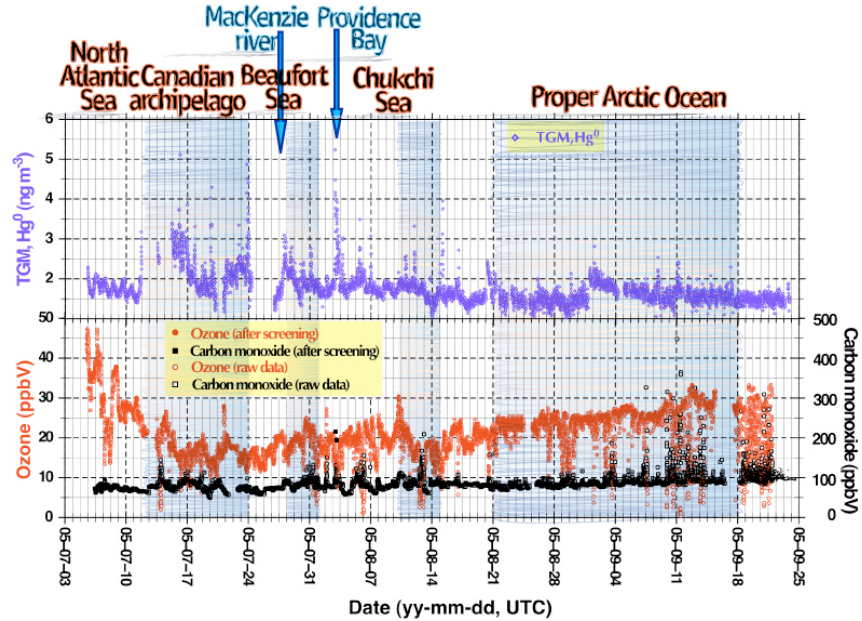
Figure 5 . 10-min averaged concentrations of atmospheric trace gases TGM, Hg 0 ; O 3 ; CO over the northern Atlantic and Arctic Ocean measured onboard the IB Oden during BERINGIA 2005. Passage through ice-covered sea is shaded in bluish colours. The names of some important geographical area discernible in Figure 1 are indicated as well.